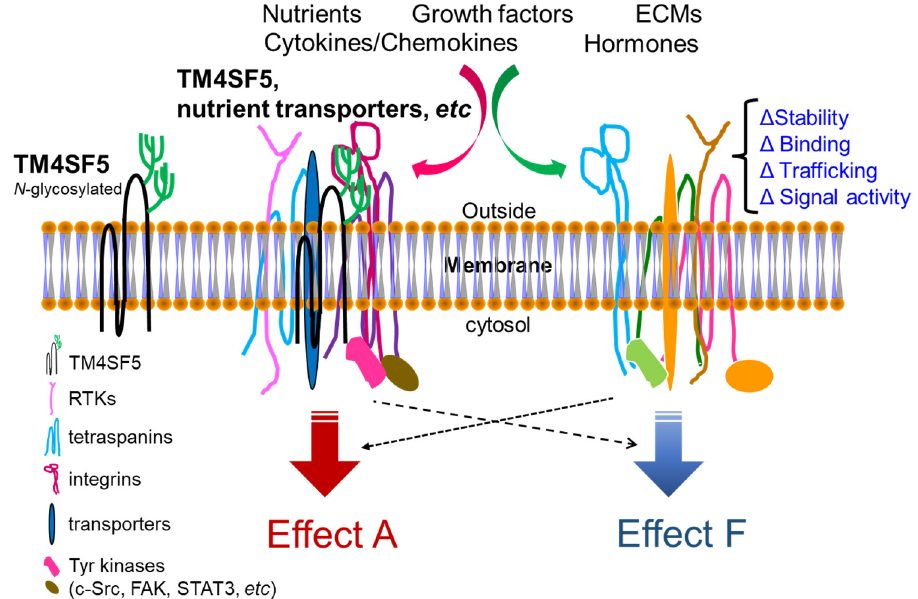
Figure 1. Working model for TM4SF5-mediated crosstalk between membrane proteins and receptors including various nutrient transporters. The N138 and N155 residues in the long extracellular loop (LEL, the 2nd extracellular loop) of TM4SF5 (197 amino acids) can be N -glycosylated, which is important for protein–protein associations. At various subcellular membranes, including plasma membranes and lysosomes, and even extracellular vesicles, TM4SF5, like the tetraspanins, associates with other membrane proteins and soluble proteins. Upon cellular needs for the metabolic regulations inside or outside cells, the TM4SF5-mediated protein complexes at T 5 ERMs may play roles in the stabilization/expression, binding, trafficking, and/or (signaling or transporting) activity of the complex components, leading to differential effects on cellular functions.